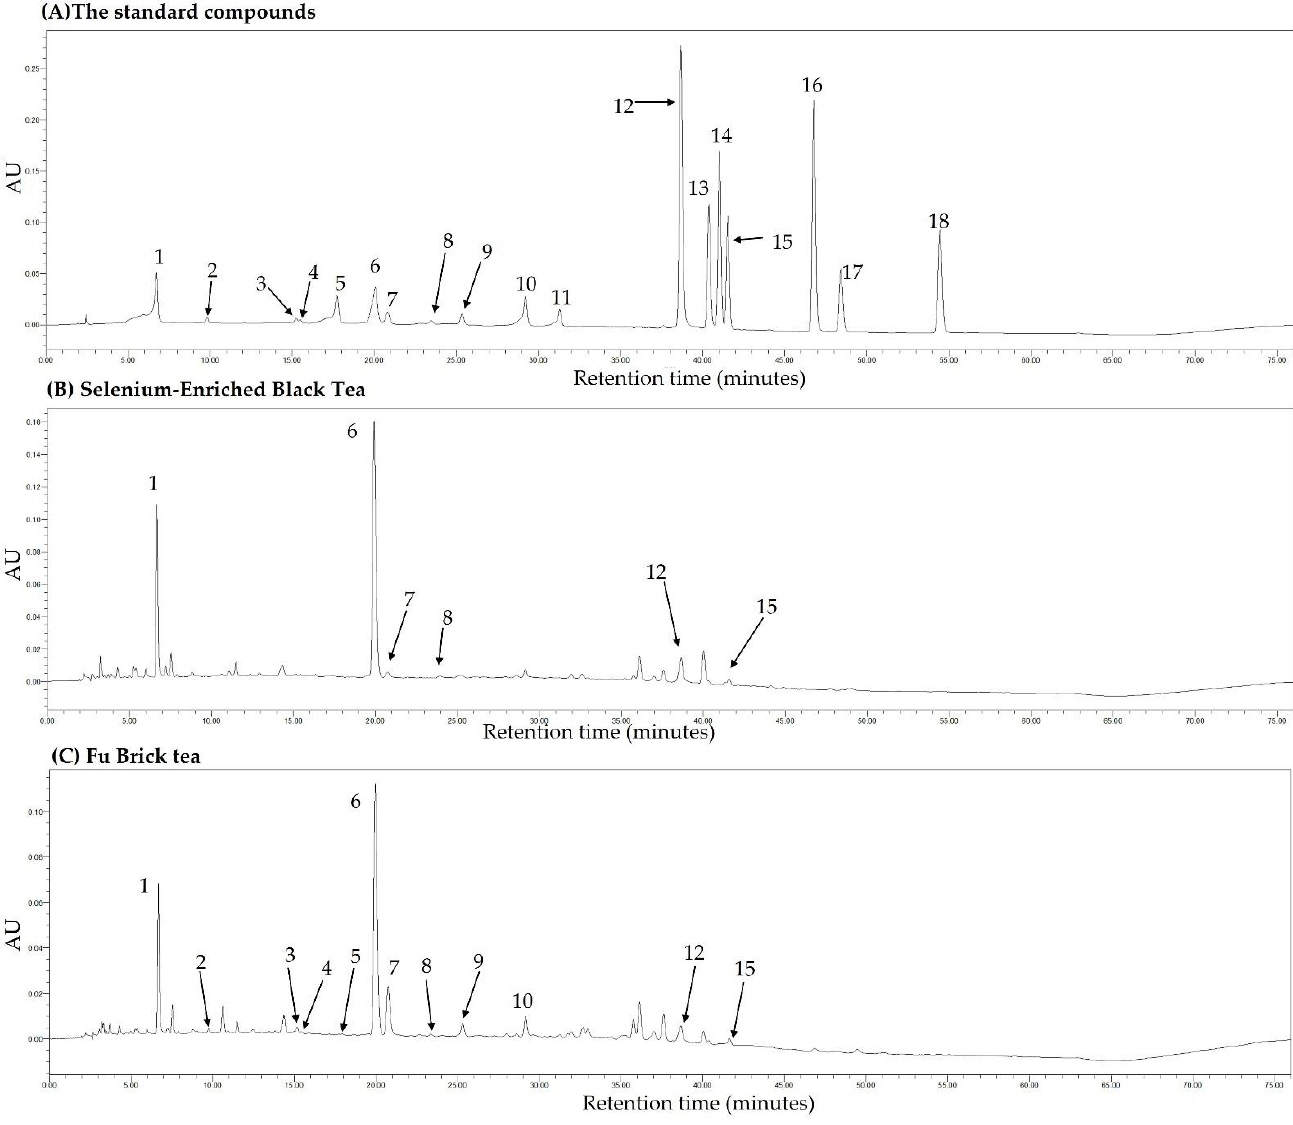
Figure 11. The HPLC chromatograms under 254 nm wavelength of the standard compounds ( A ), selenium-enriched black tea ( B ), and Fu brick tea ( C ). 1, gallic acid; 2, gallocatechin; 3, epigallocatechin; 4, catechin; 5, chlorogenic acid; 6, caffeine; 7, epigallocatechin gallate; 8, epicatechin; 9, gallocatechin gallate; 10, epicatechin gallate; 11, catechin gallate; 12, ellagic acid; 13, myricetin; 14, quercitrin; 15, astragalin; 16, quercetin; 17, theaflavin; 18, kaempferol.